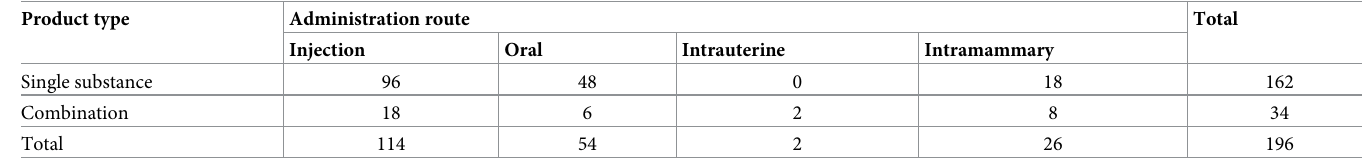
Table 2. Distribution of antimicrobial products approved for use in cattle in Japan by administration route and number of active ingredients contained. Product type